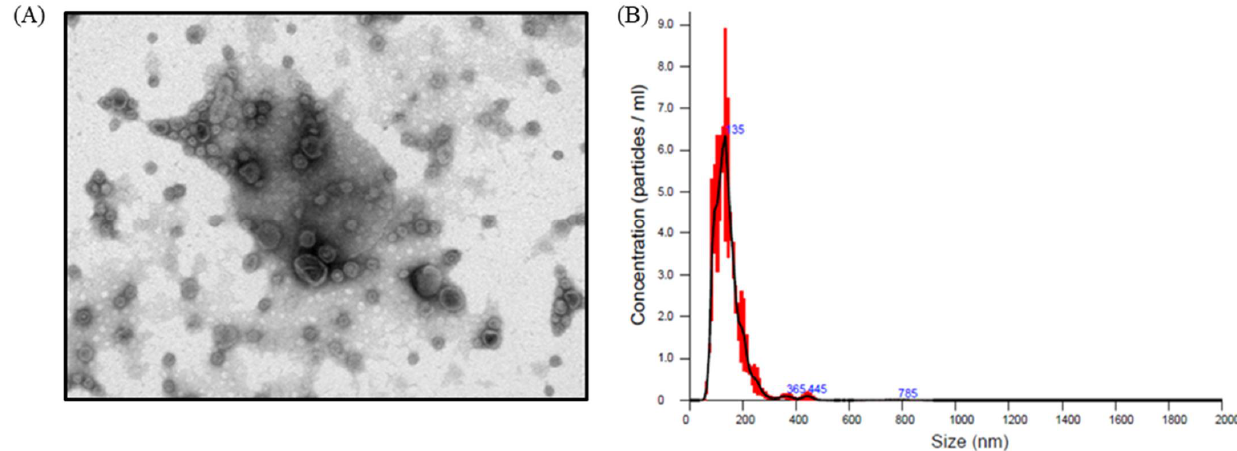
Figure 5. The characteristics of extracellular vesicles (EVs) derived from F. nucleatum . ( A ) Morphology of EVs by transmission electron microscope and ( B ) size distribution of EVs by nanoparticle tracking analysis.